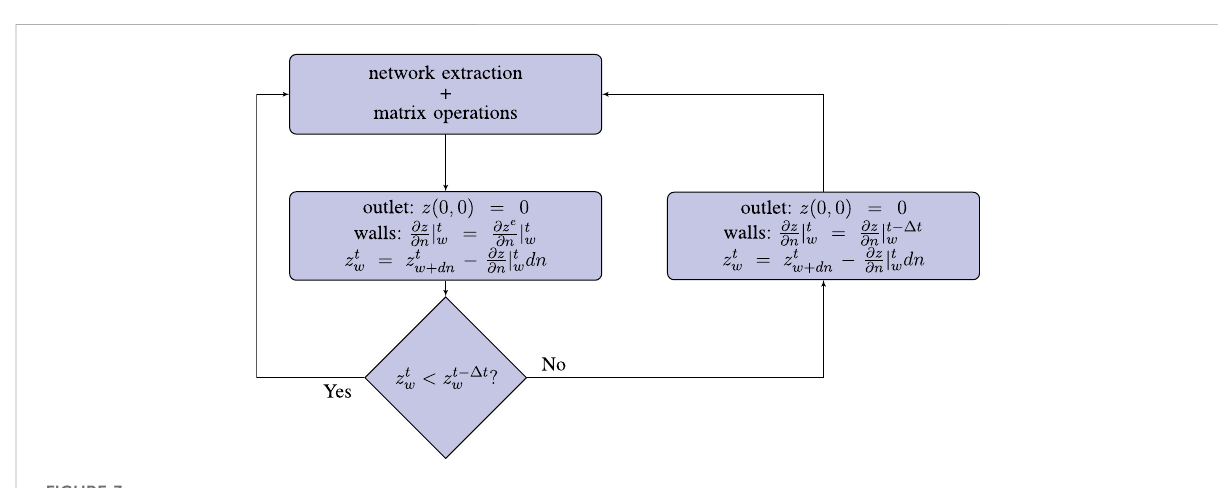
FIGURE 3 The wall boundary condition assuming (cid:2) n as the outward unit vector normal to the wall. The term z z e z n | t w was calculated by linear interpolation between the two consecutive scans before and after the time t